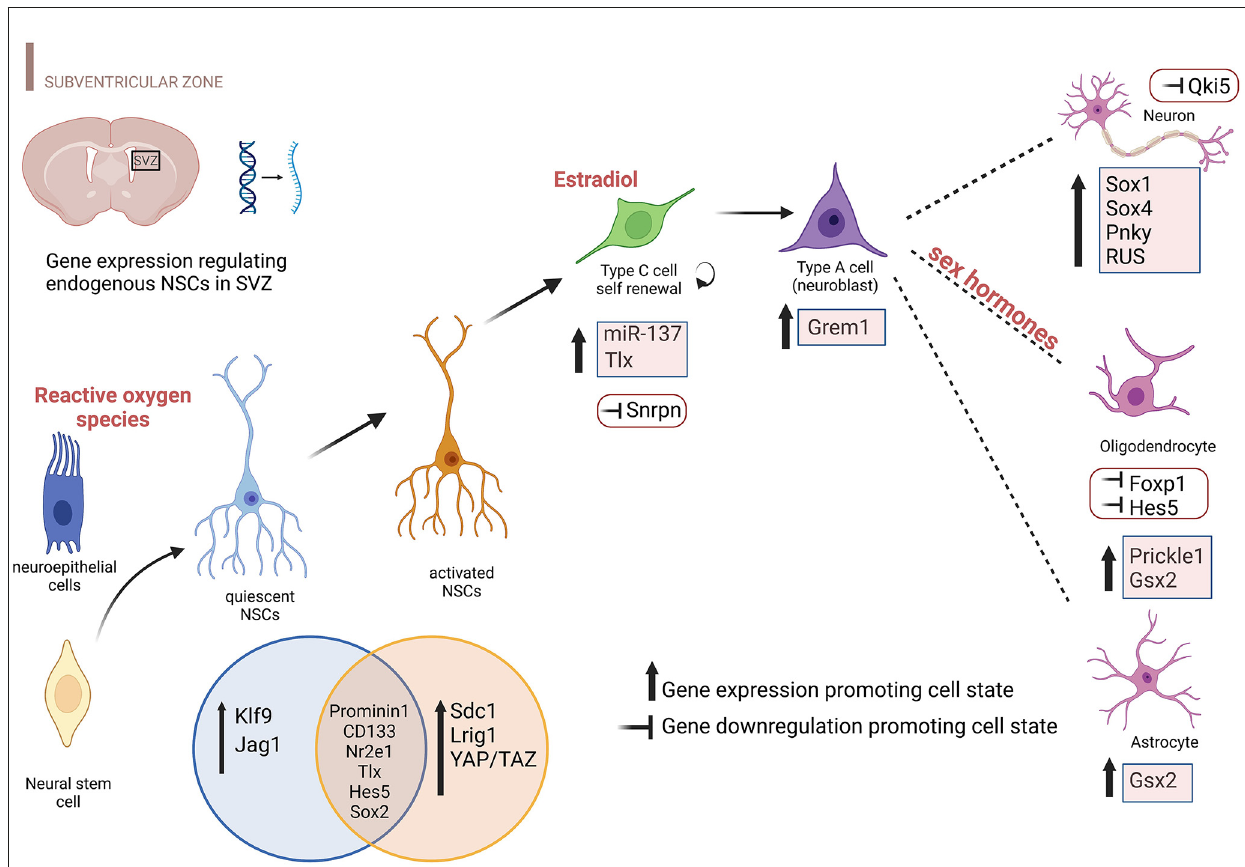
FIGURE1 Environmental factors and differentially expressed genes promoting specific NSC states in the SVZ. The cartoon highlights the transcript perturbations that favor each cellular state during brain development including the prenatal and postnatal period, specifically for the SVZ. Both upregulation and downregulation of gene expression are reported including environmental factors that influence neuroepithelial cells (ROS), NBs (estradiol), and Ols (sex hormones). Genes reported include protein-coding genes, TFs, lncRNAs, and microRNAs. This figure has been realized using